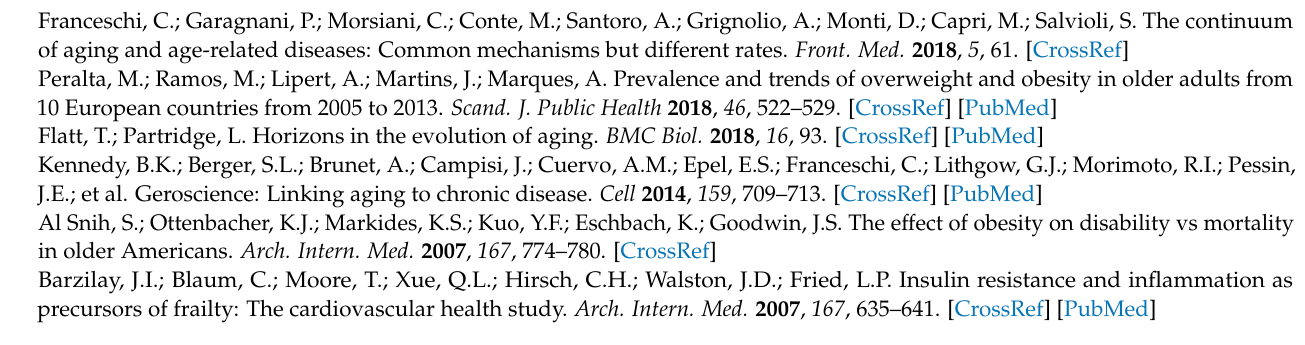
units within 2 years, Table S7. Physical activities frequency as predictors of changes in body fat percent within 2 years, Table S8. Physical activities frequency as predictors of changes in muscle mass in kilograms within 2 years, Table S9. Physical activities frequency as predictors of changes in visceral fat in units within 2 years, Table S10. Relationship between frequency of drinking beer to the increased vs. decreased body fat, Table S11. Relationship between frequency of drinking green or white tea to the increased vs. decreased body fat, Table S12. Relationship between frequency of drinking coffee to the increased vs. decreased body fat, Table S13. Relationship between frequency of sweets consumption to the increased vs. decreased body fat, Table S14. Relationship between frequency of green/white tea and coffee consumption, Table S15. Relationship between frequency coffee and sweets consumption